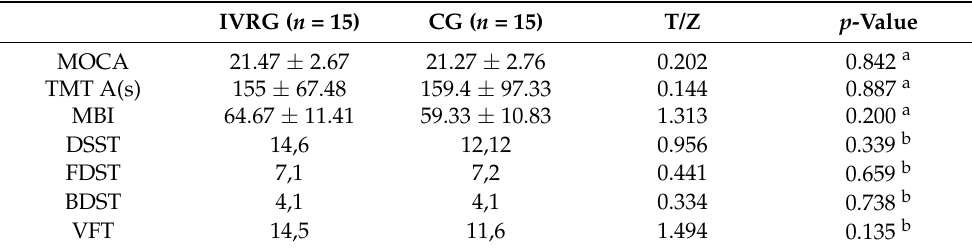
Table 2. Comparisons of baseline cognitive evaluation between the IVR and control groups before treatment.